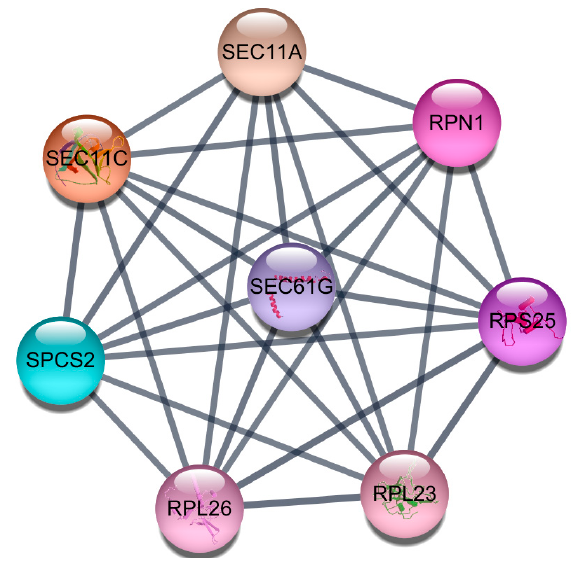
Figure 1. The most significant protein-protein interaction (PPI) sub-module detected by the MCODE algorithm, which includes eight hub molecules, Signal Peptidase Complex Subunit 2 ( SPCS2 ), Ribosomal Protein L23 ( RPL23 ), Ribosomal Protein L26 ( RPL26 ), Ribophorin I ( RPN1 ), SEC11 Homolog C, Signal Peptidase Complex Subunit (SEC11C), SEC11 Homolog A, Signal Peptidase Complex Subunit ( SEC11A) , Ribosomal Protein S25 ( RPS25 ), and Sec61 Translocon Gamma Subunit ( SEC61G ). These hub molecules might play crucial roles in development of parathyroid adenoma. Of them, RPL23 had the highest score, indicating that it was the most strongly interconnected with its neighbor proteins.